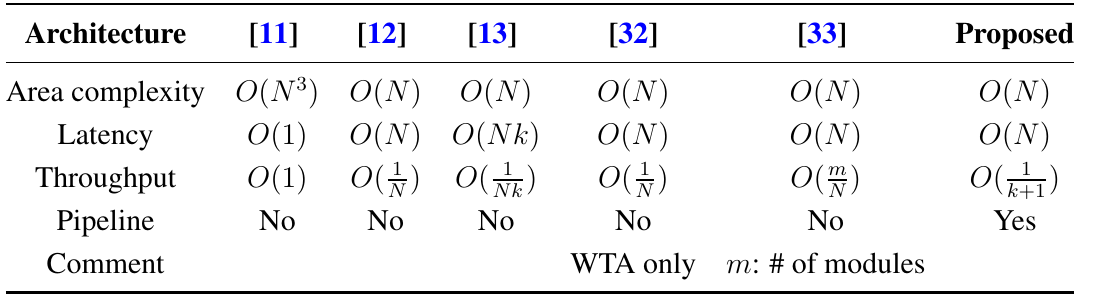
Table 4. Performance analyses for different